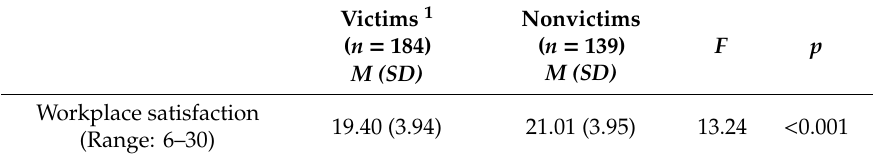
Table 1. Workplace satisfaction: comparison between victims and nonvictims (one-way ANOVA). Victims 1